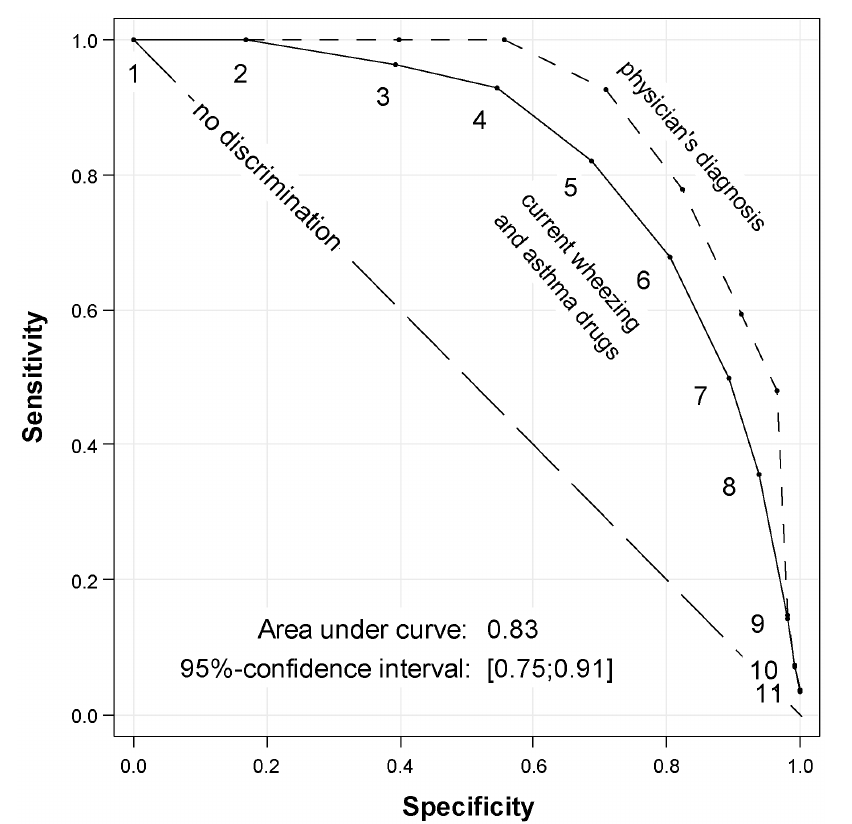
Fig. 3. Receiver Operating Characteristic (ROC) using external validation sample. Primary inclusion and scoring definitions. Outcome definitions: Primary (current wheezing and asthma drugs at 8y, solid line) and secondary (physician’s diagnosed asthma at 8y, dashed line). Numbers indicate asthma prediction score values. The area under the curve (AUC) and confidence interval corresponds to the primary outcome.